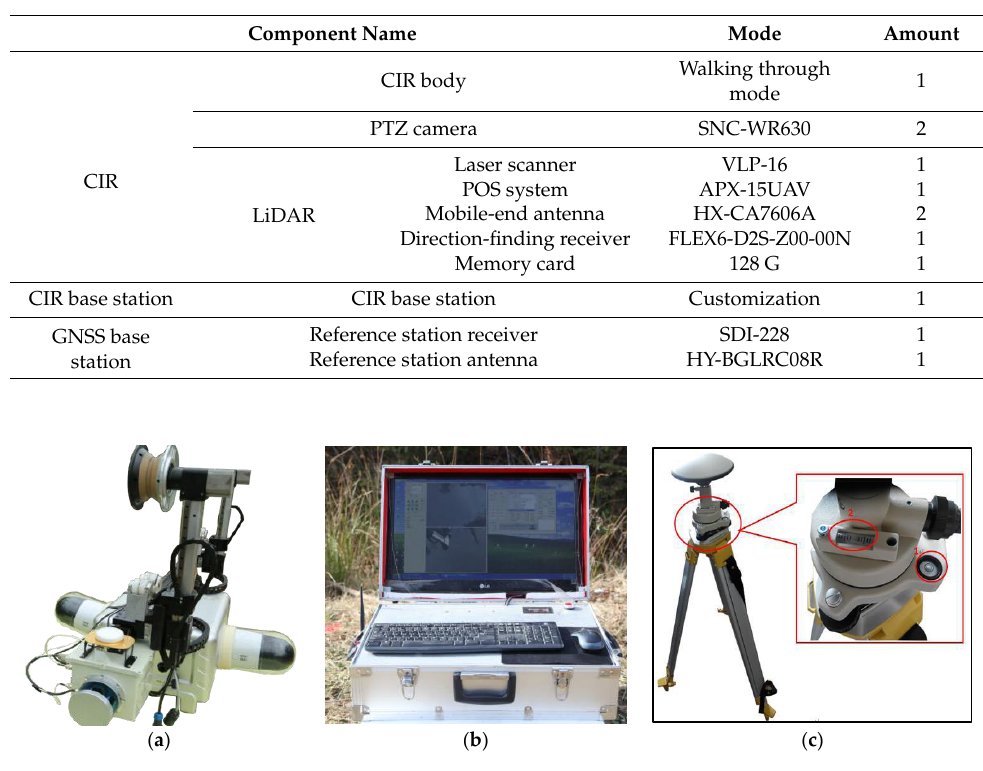
Figure 2. Photos of the autonomous inspection system: ( a ) CIR body; ( b ) base station; ( c ) GNSS base station.